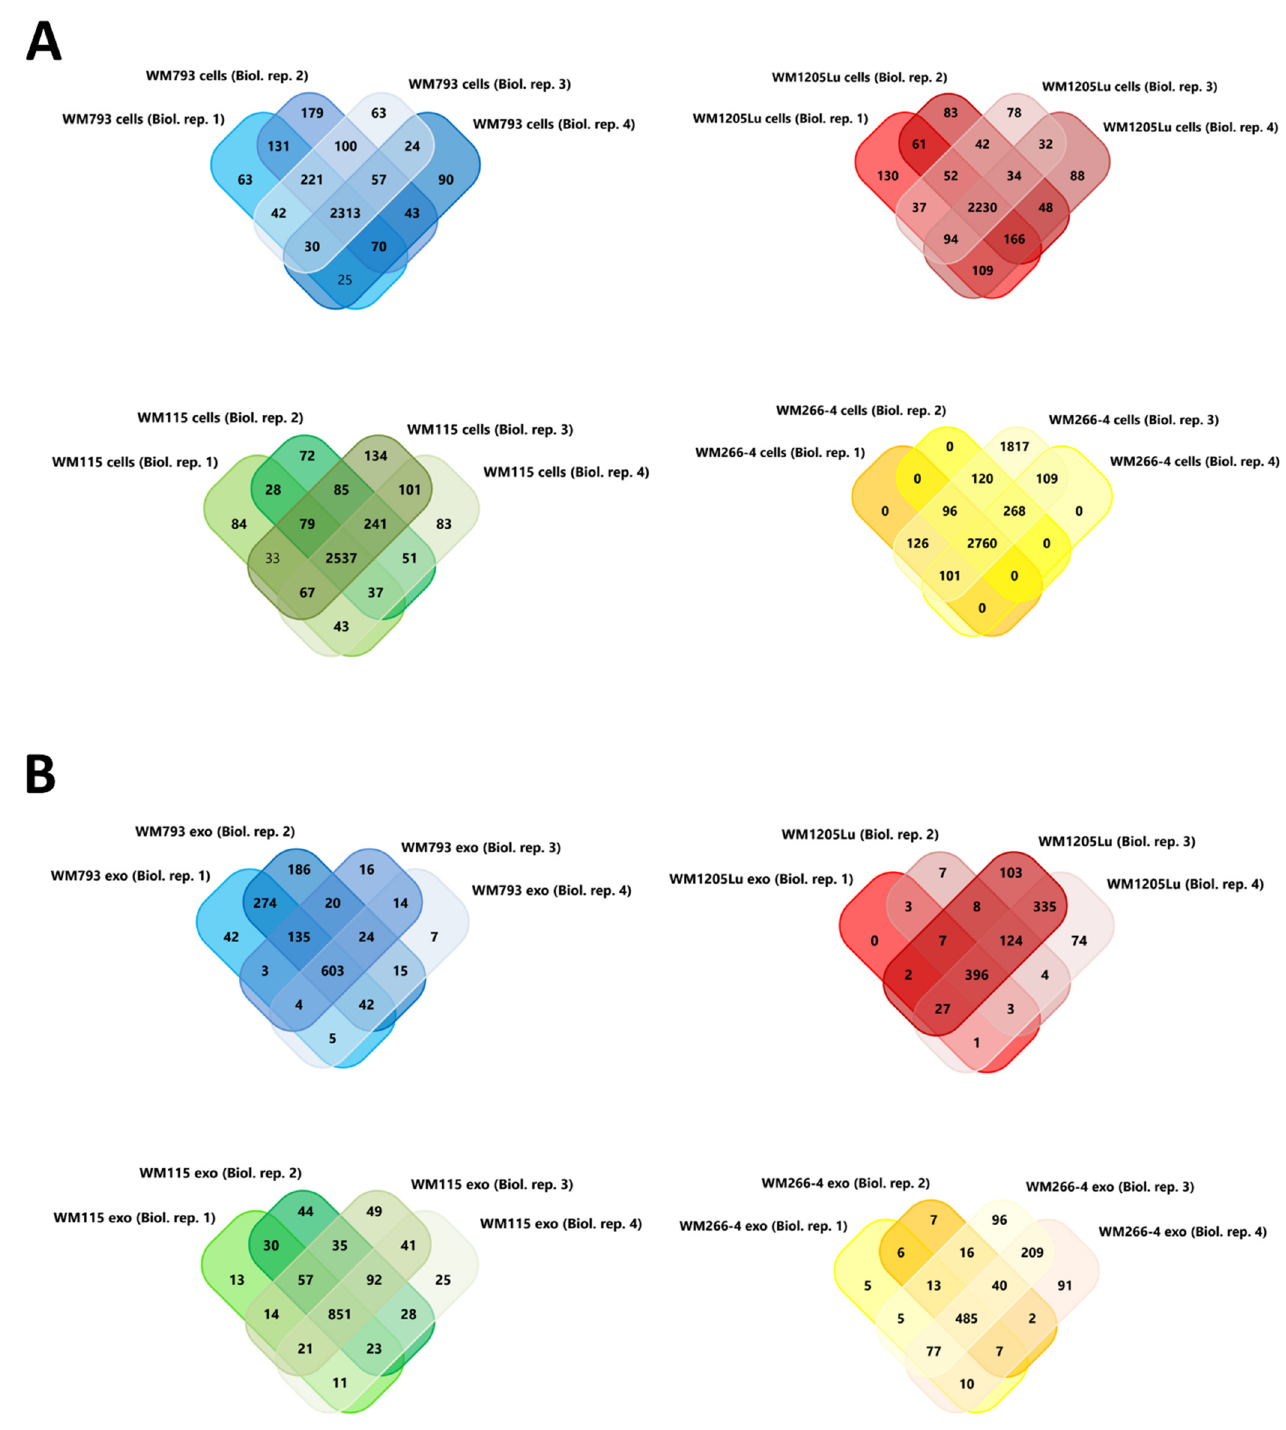
Figure A1. Venn diagrams illustrating the number of proteins shared between biological replicates of given CM cell ( A ) and ectosome ( B ) samples.